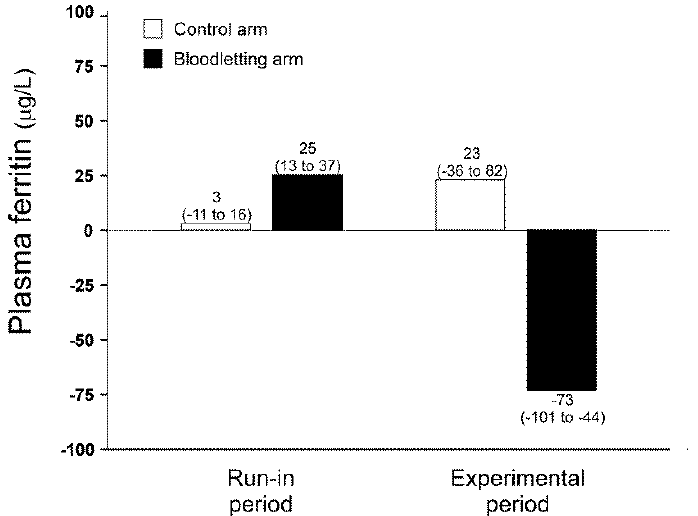
Figure 3. Changes in circulating ferritin in each arm of the trial throughout the study. Data are shown as mean of the differences and 95% CI.